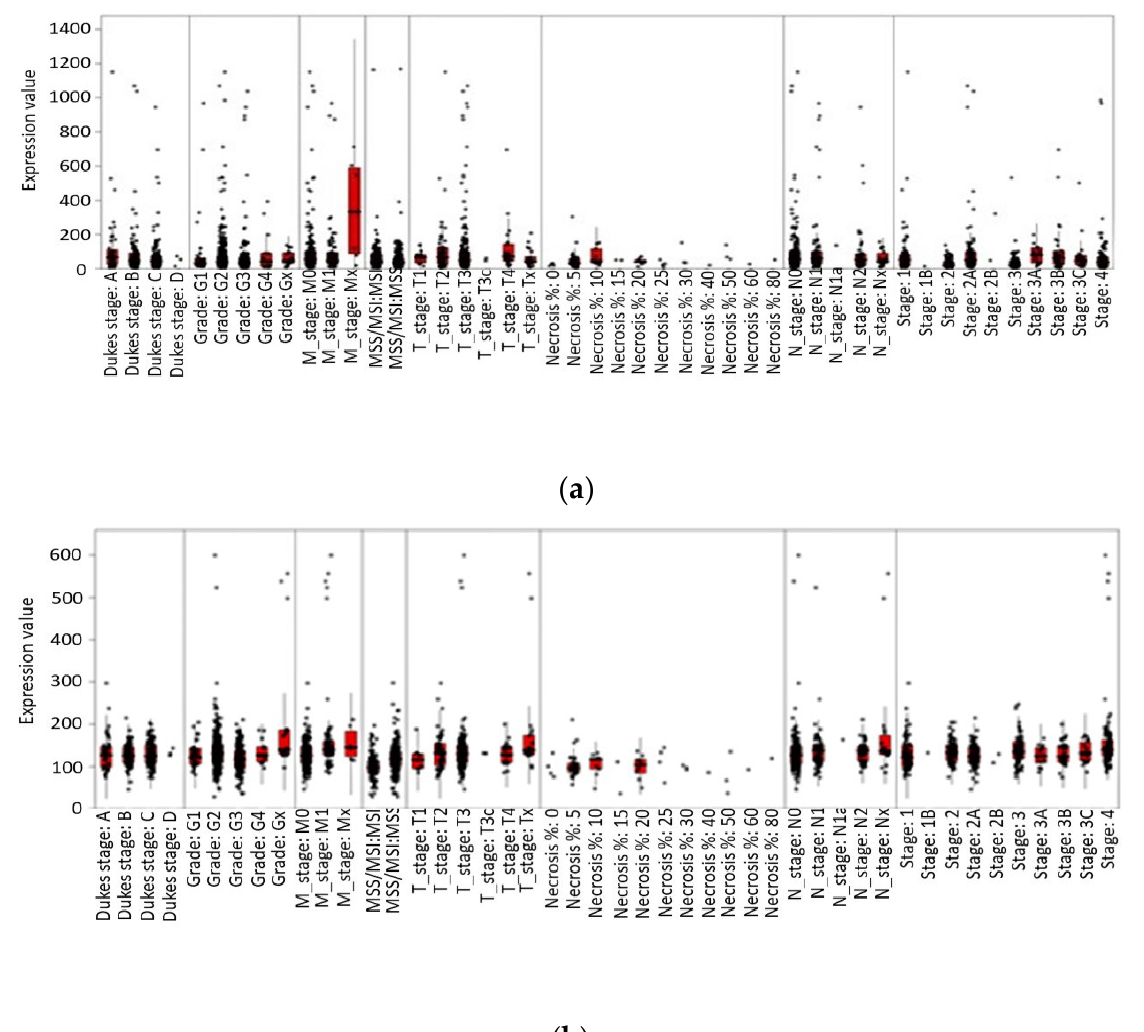
Figure 4. LEP and LEPR gene expression association with colorectal cancer phenotypes. Data represent the expression values of LEP ( a ) and LEPR ( b ) in colorectal cancer samples with several types of clinical data, within each cancer dataset. Each sample is represented by a single datapoint. Each type of clinical data exists as a column within a separate segment of the phenoplot. Expression values are also presented as red box plots. Boxes represent samples with distinct phenotypic values as black dots in the clinical data segments. A box is only shown if there are more than five distinct phenotypic values. Data were retrieved from the online IST database (https://ist.medisapiens.com/, accessed on 24 June 2021).